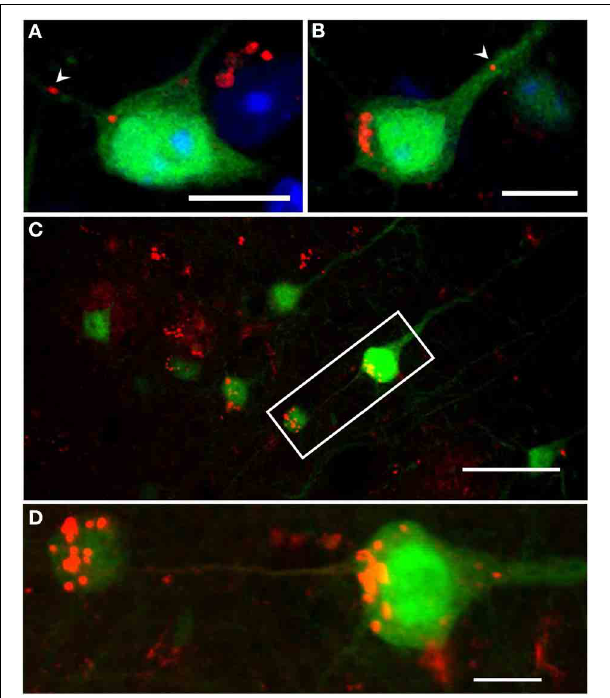
FIGURE 8 | Confocal images of intraneuronal A β accumulation in cortical neurons of 6-month-old YFP/APP/PS1KI he mice. A β accumulated inside cell bodies at the axon hillock (A,B) , as well as in axons ( A , arrowhead) and large apical dendrites ( B , arrowhead) projecting from the cell body (OC antibody, red). Also, axonal swellings accumulating intracellular A β were found directly connected to cortical neurons accumulating abundant amounts of intraneuronal A β at the axon hillock (A β [N] antibody, red) ( C,D : enlargement of C ). Scale bars: (A,B,D) : 10 μ m; (C) : 40 μ m.